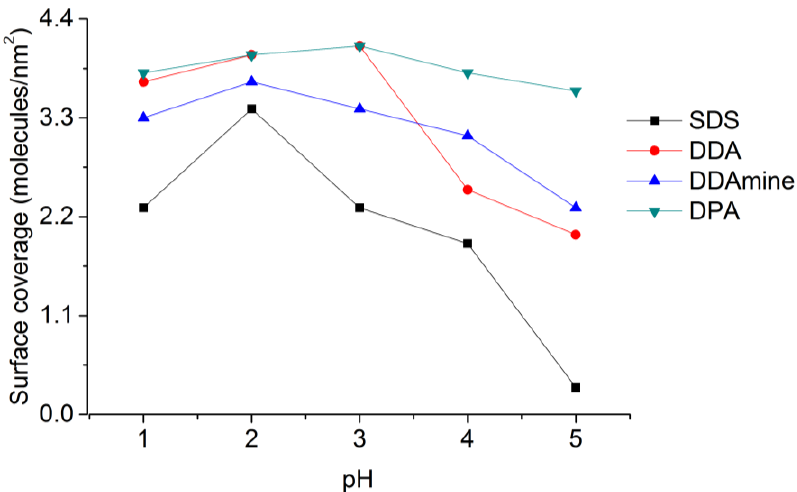
Figure 12. Effect of pH on surface coverage of titania by the four coupling